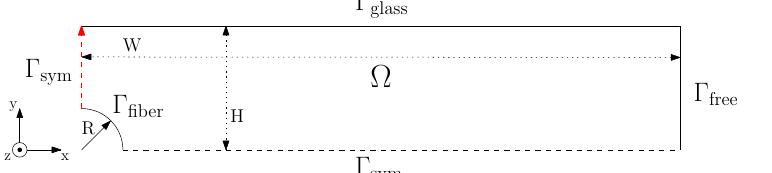
Figure 3. Schematic representation of the fiber-pulling problem. Only a quarter of the actual geometry is modeled because of internal symmetry.